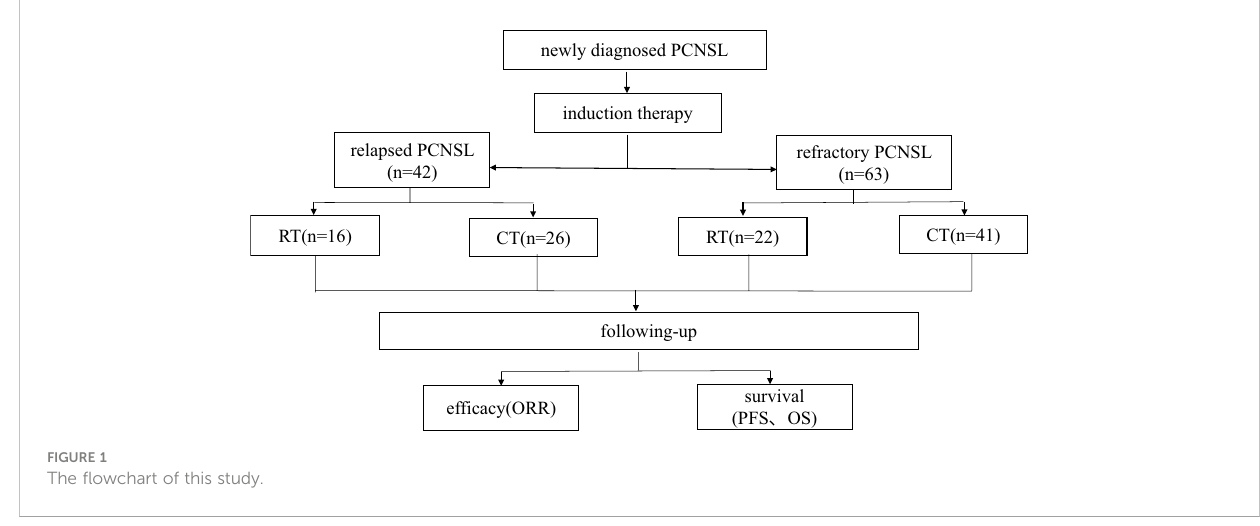
FIGURE 1 The fl owchart of this